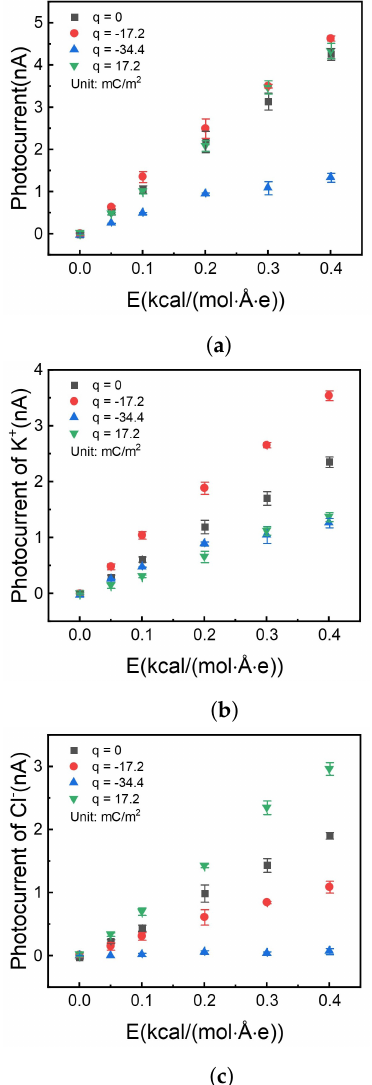
Figure 7. Photocurrent vs. different electrical fields with different charge densities on the internal surface of the nanochannel. ( a ) Total photocurrent. ( b ) Photocurrent offered by potassium ion. ( c ) Photocurrent offered by chloride